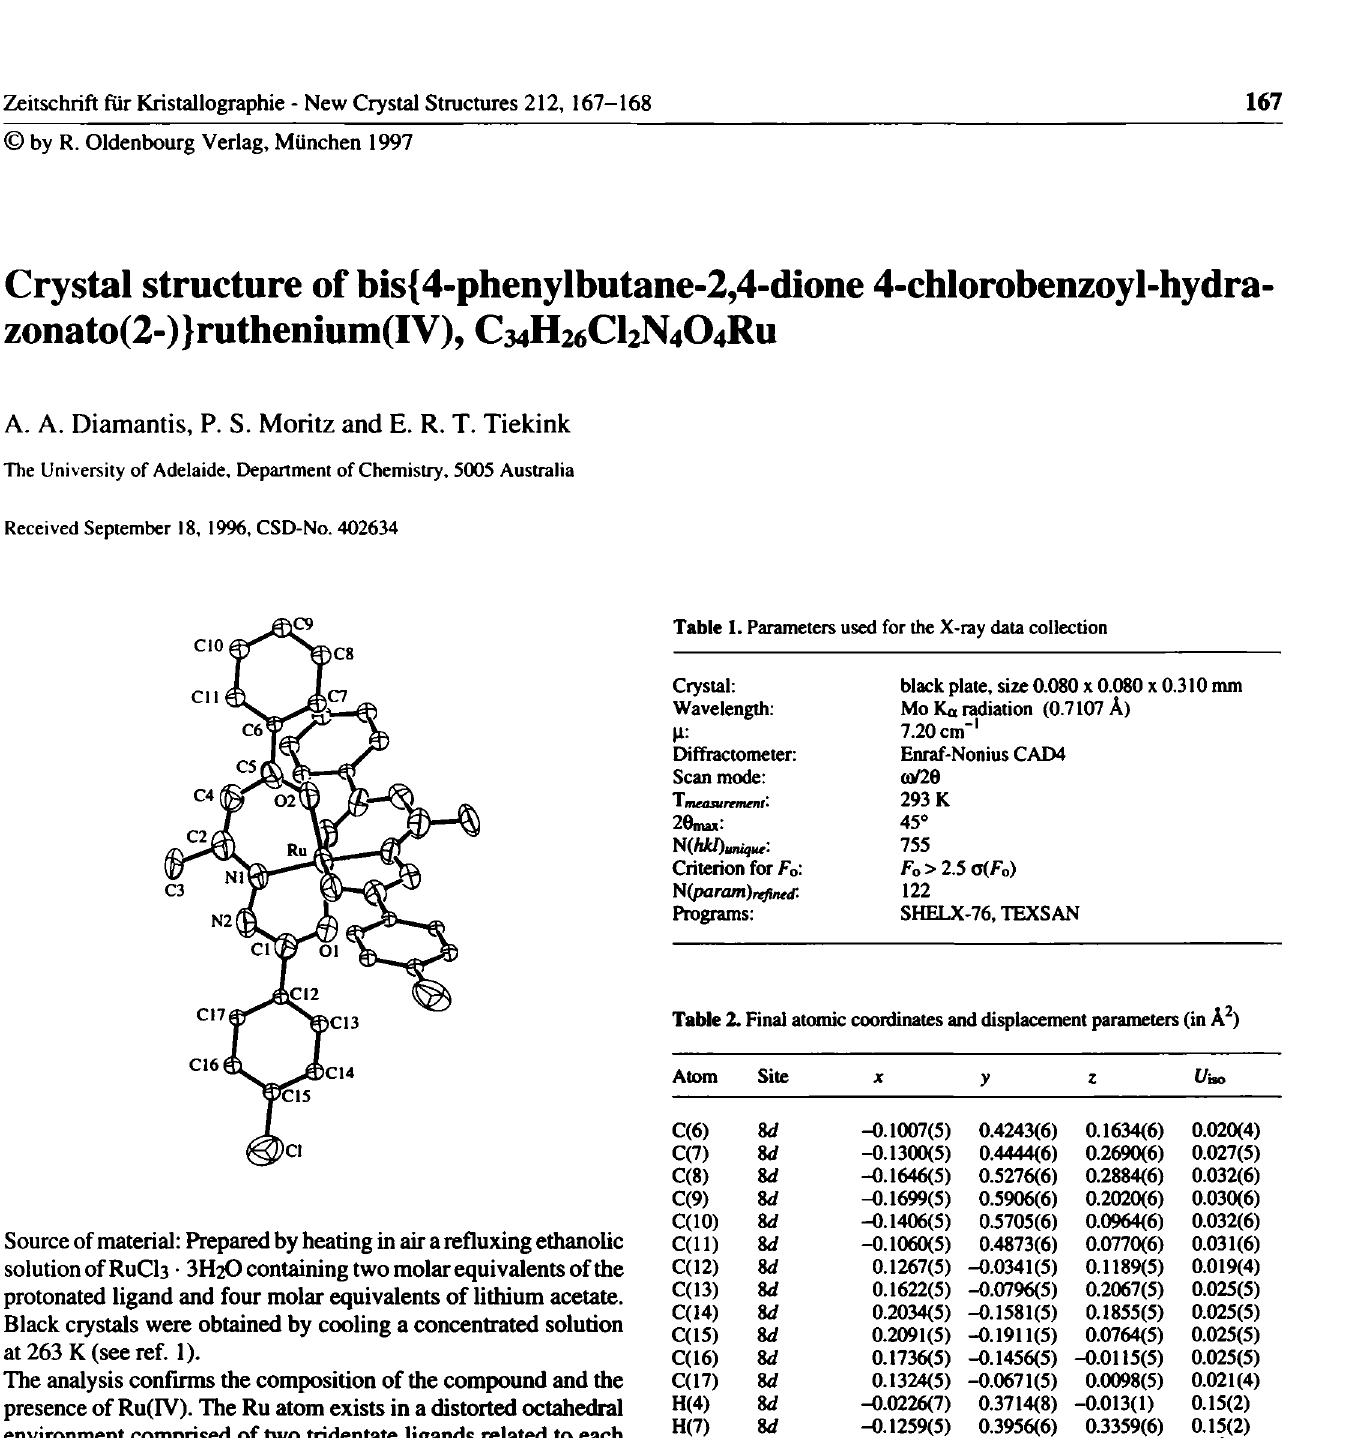
Table 2. Final atomic coordinates and displacement parameters (in À 2